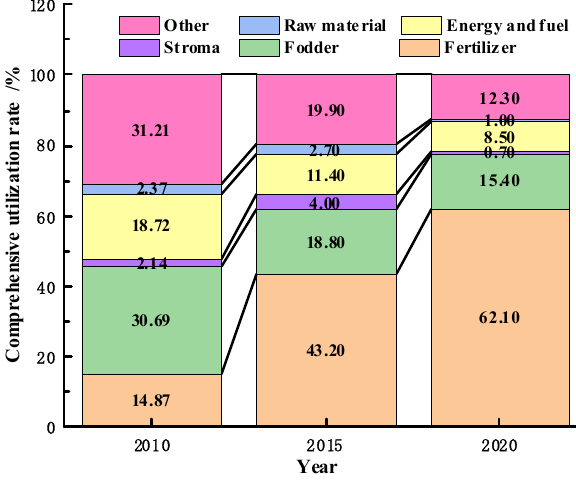
Figure 1. The comprehensive utilization of crop straw in 2010, 2015, and 2020.